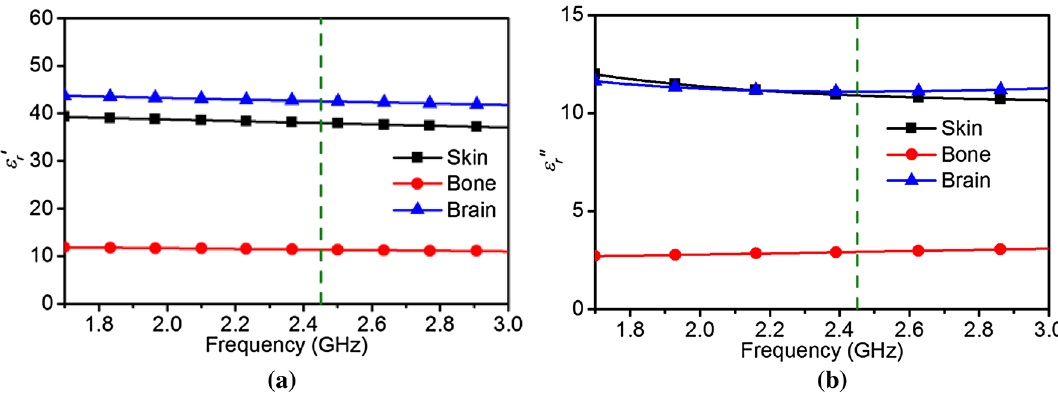
Figure 1. ( a ) Real and ( b ) imaginary permittivity of human skin, bone and brain (derived from 18 ). The dashed lines indicate the selected